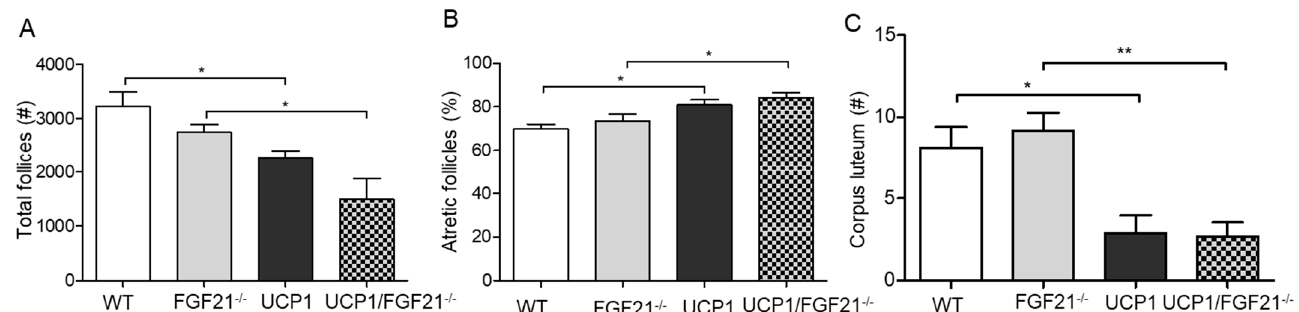
Figure 5. FGF21 and ovarian follicular development. Numbers of healthy follicles ( A ), percentage of atretic follicles ( B ), and numbers of corpora lutea ( C ) in WT (white), FGF21 knock out (FGF21 –/– ; grey), UCP1-TG (UCP1; black) and FGF21 –/–/ UCP1-TG (FGF21 –/– /UCP1) mice (mixed). Data are expressed as mean +/ − SEM ( n = 6–8); #, numbers; %, percentage; ( A – C ): one-way ANOVA; *, p < 0.05; **, p < 0.01.